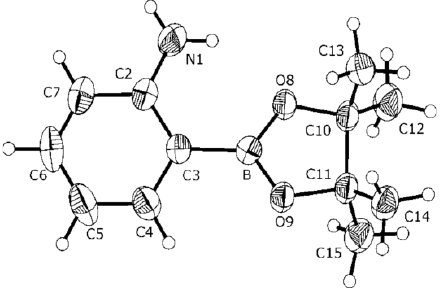
Figure 2. The molecular structure of 2-APBpin with displacement ellipsoids shown at 30% probability level. Selected bond distances (Å) and angles ( o ): B-O(8) 1.3690(16), B-O(9) 1.3705(16), B-C(3) 1.5467(18), N(1)-C(2) 1.3622(18), B-N(1) 2.974(2); O(8)-B-O(9) 112.76(11), O(8)-B-C(3) 123.99(11), O(9)-B-C(3)